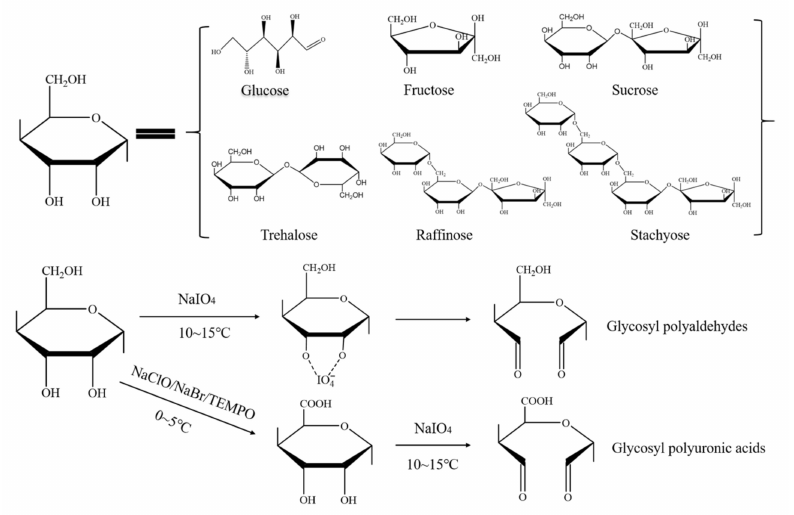
Figure 2. Schematic of preparation mechanism of glycosyl anti-wrinkle finishing